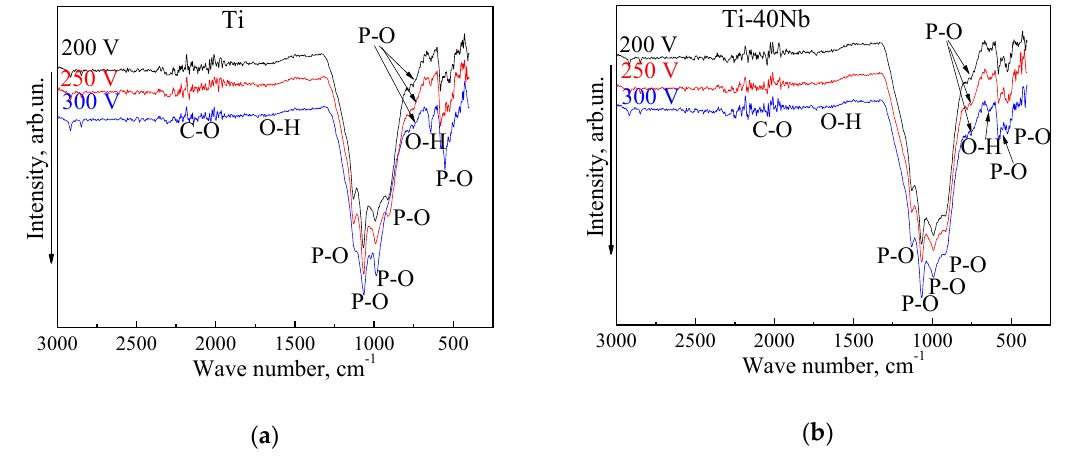
Figure 8. Typical FT-IR spectra of the MAO coatings deposited at different voltages on both Ti ( a ) and Ti-40Nb ( b ) substrates.